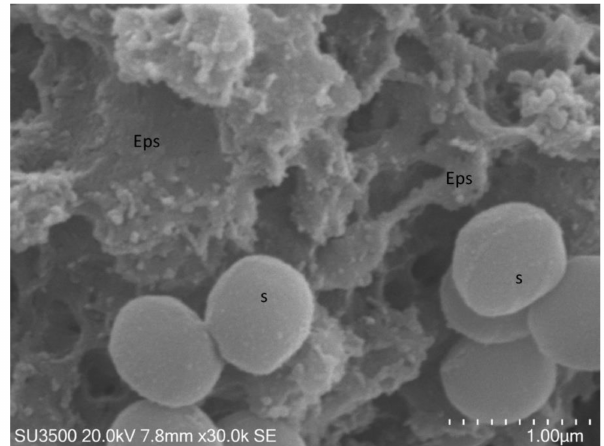
Figure 7. S. mutans prepared by the conventional SEM protocol. At high magnification, 30,000 × , Eps appeared as a collapsed network of filaments, cell surface, s, was naked, and not covered by Eps.